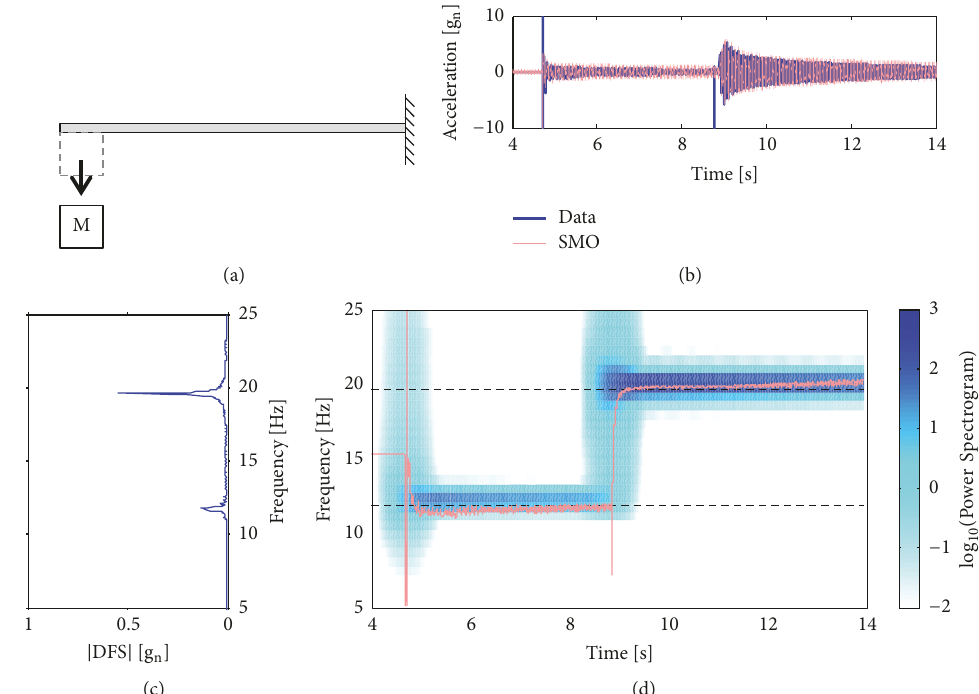
Figure 5: Results from the mass drop experiment. (a) Diagram of the mass dropping from the beam. (b) Amplitude of the discrete Fourier series (DFS) of the tip acceleration. (c) Time history of the tip acceleration. (d) Spectrogram of the tip acceleration when the mass drops. The horizontal dashed lines indicate the frequencies for the first natural frequency with and without the added